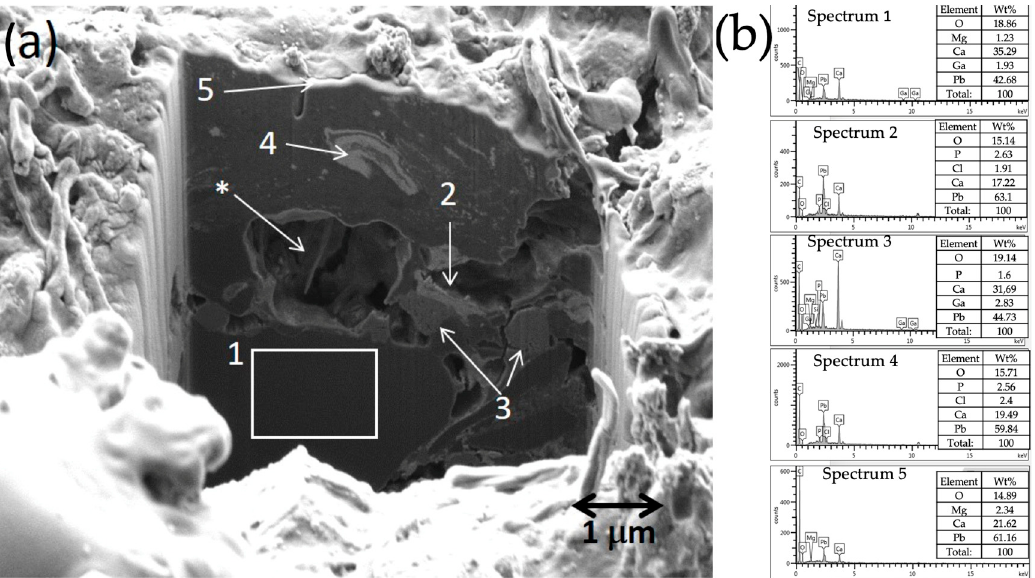
Figure 10. ( a ) Secondary electron image of the trench performed in sample K-4; ( b ) X-ray spectra acquired in different cross-section points (see points 1–5 in Figure 10a). (*) point where hyphae infiltrate the varnish.